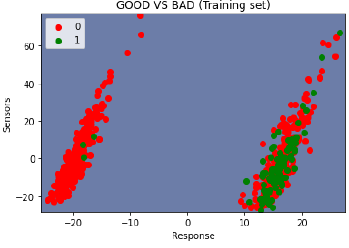
Figure 12. Training set of Good vs Bad data